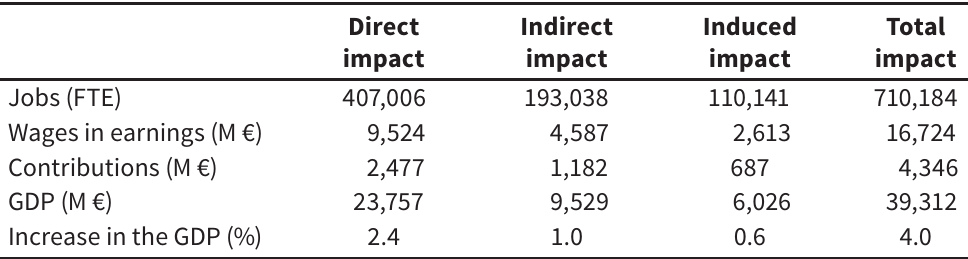
Macroeconomic impact of the full workforce integration of persons with disabilities, 2015